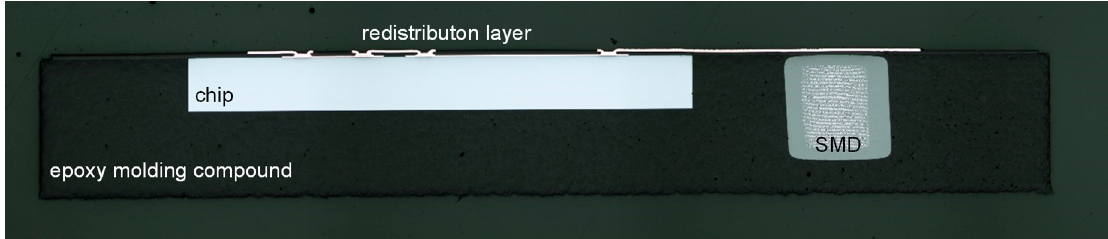
Figure 11. Package cross section; ASIC with SMD component embedded in the molding compound and connected by a thin film redistribution layer.